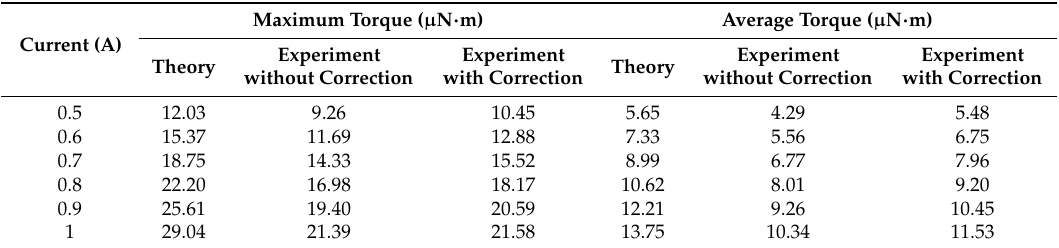
Table 7. Torque characteristics of the single-phase switched reluctance motor with and without friction correction.